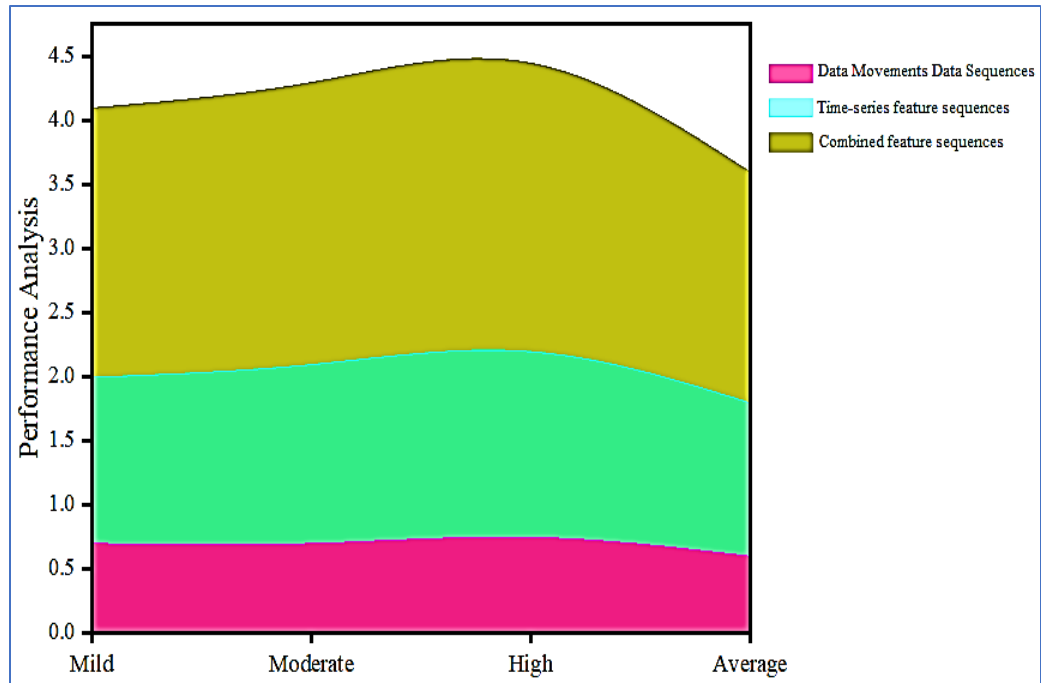
Figure 5. F1 data categories of the BP neural network with three varying inputs for the vocational course.